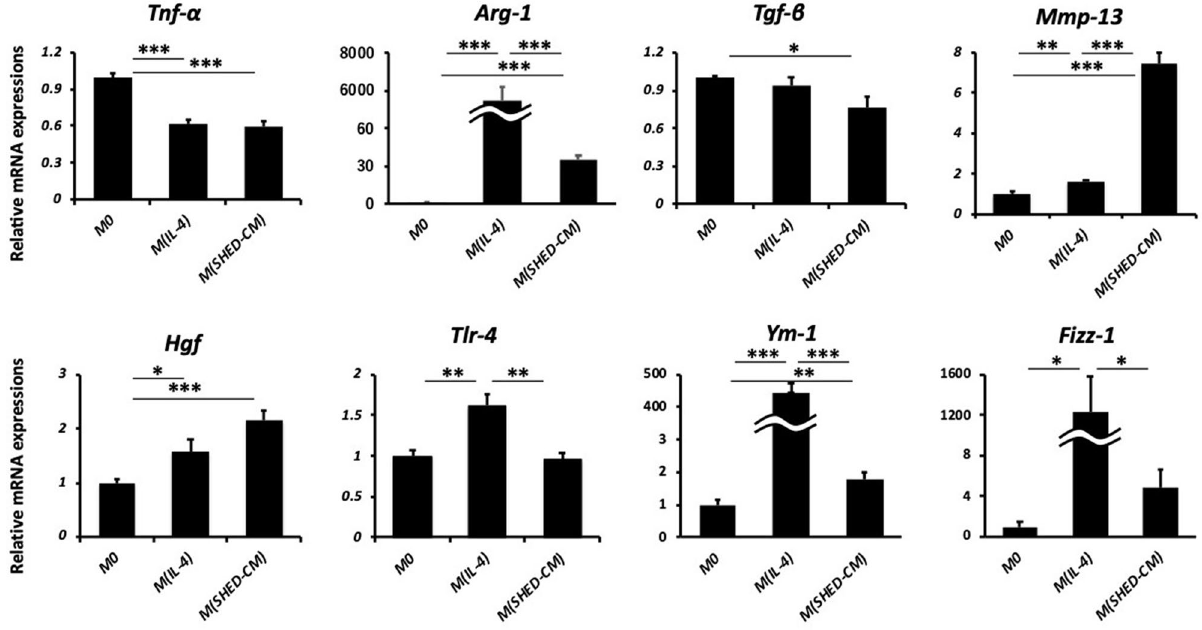
Figure 5. Relative mRNA expression levels of indicated genes in the treated bone marrow-derived macrophages. Data represent mean ± SEM. * P < .05; ** P < .01; *** P < .001. Abbreviations: Tnf, tumor necrosis factor; Arg, arginase; Tgf, transforming growth factor; Mmp, matrix metalloproteinase; Hgf, hepatocyte growth factor; Tlr, toll-lile receptor; Fizz-1, found in inflammatory zone